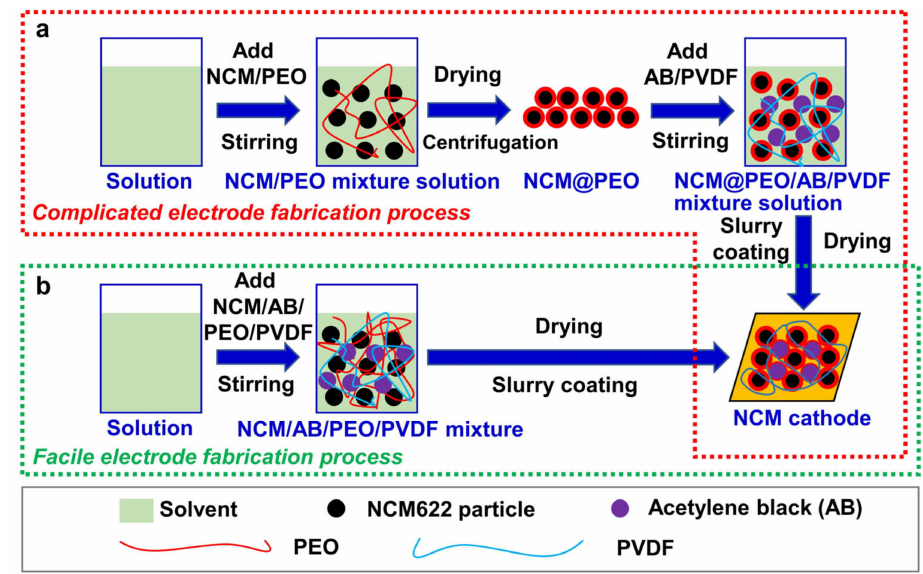
Figure 1. Schematic illustrations of the fabrication of NCM622 cathodes by ( a ) PEO coating on NCM622 particles and ( b ) by using PEO as a binder additive followed by slurry coating and drying